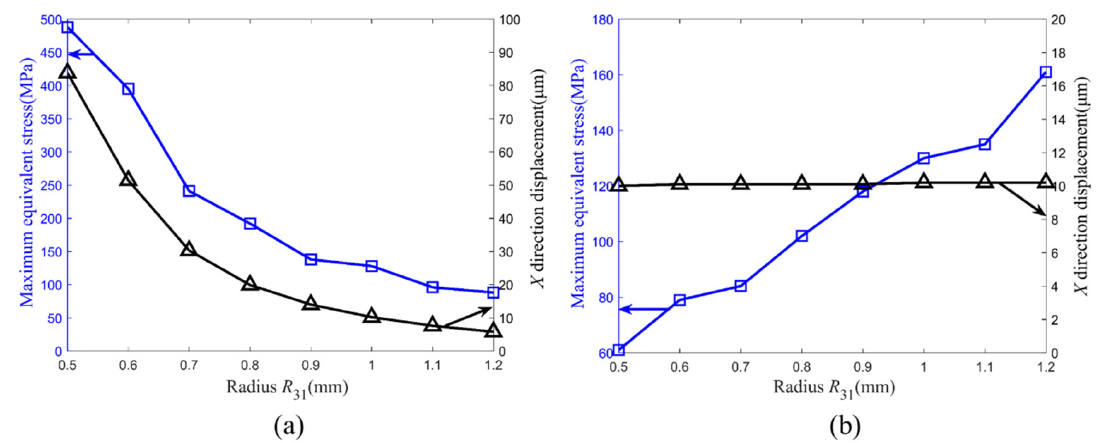
Figure 3. Boundary conditions for simulation of the stator.